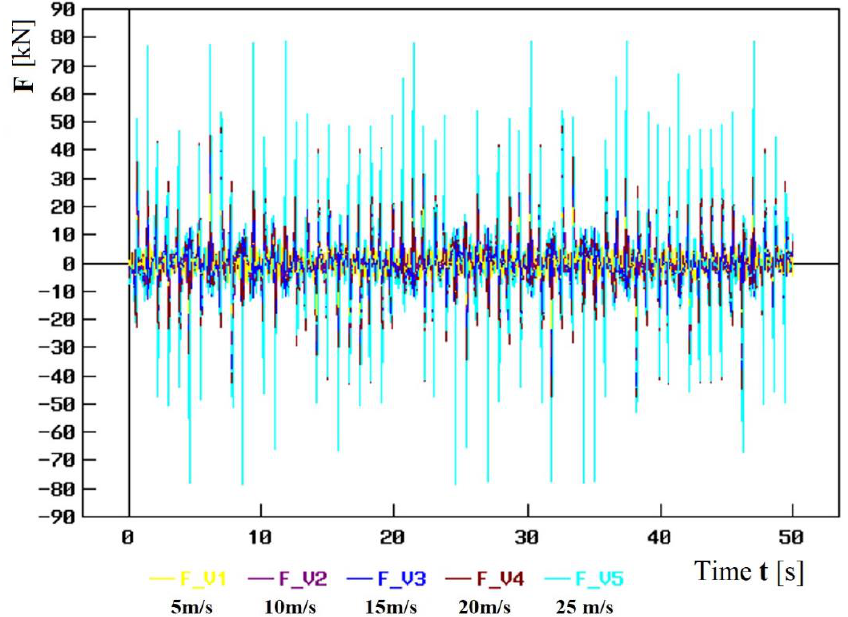
Figure 13. The complete realization of the input F(t), i.e., the dynamic component of the vertical force on the connection between the tractor ’ s fifth wheel and the kingpin of the semitrailer, for road C (average) and the five vehicle speed values v considered: 5 m/s, 10 m/s, 15 m/s, 20 m/s, and 25 m/s.